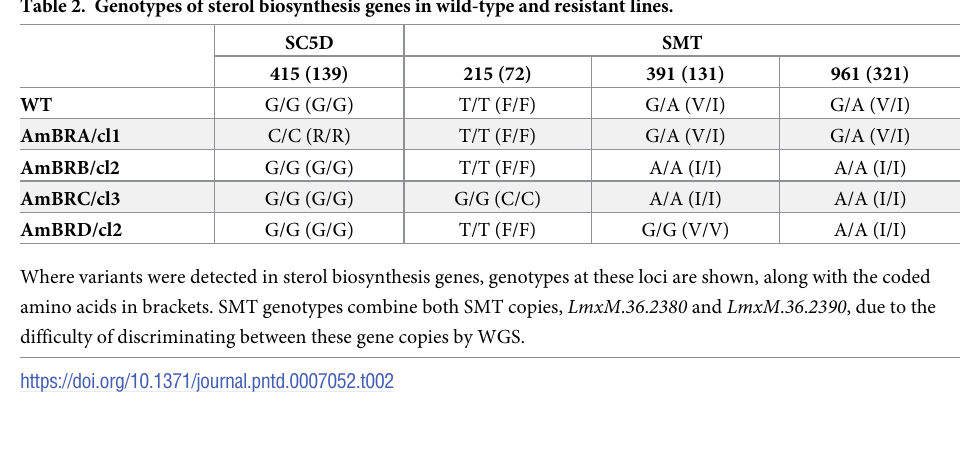
Table 2. Genotypes of sterol biosynthesis genes in wild-type and resistant lines. SC5D